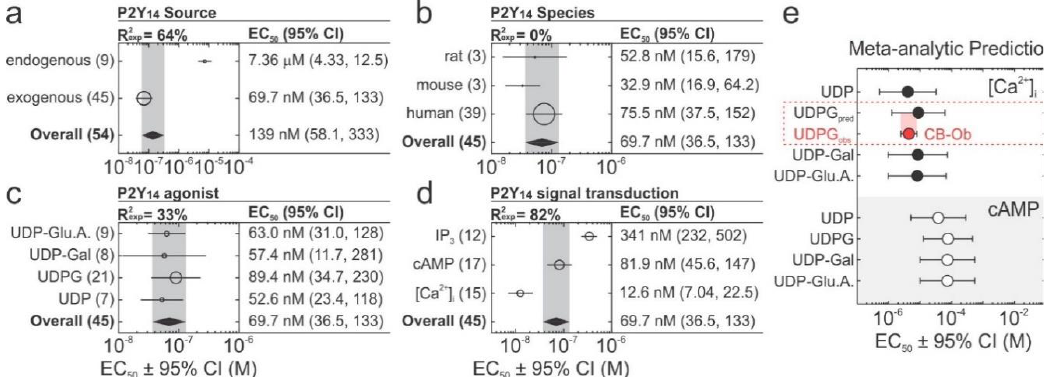
Figure 7. A meta-analysis of P2Y 14 signalling. ( a – d ) Study-level P2Y 14 EC 50 values were estimated by hill functions (fitted to study-level data) and pooled using a random-effects model to obtain subgroup EC 50 estimates for ( a ) P2Y 14 source (endogenous or exogenous); ( b ) P2Y 14 species (human, mouse, or rat); ( c ) uridine agonists used to evoke the response (UDP, UDP-glucose, UDP-galactose, or UDP glucuronic acid); and ( d ) measured outcome (IP 3 , cAMP, or [Ca 2+ ] i ). Panels b – d only included exogenously expressed P2Y 14 data, and IP 3 and [Ca 2+ ] i responses were measured in heterologous expression systems using chimeric Gα protein. 𝑹 𝒆𝒙𝒑𝟐 : Percentage of heterogeneity (i.e., inconsistency between datasets) explained by specified covariates, circles/lines : subgroup means ± 95% CI (marker sizes are proportional to the number of datasets that are shown in parentheses), diamonds/grey bands : overall means ± 95% CI. ( e ) The meta-regression model was used to predict EC 50 of [Ca 2+ ] i response induced by endogenously expressed murine P2Y 14 , and prediction (UDPG pred ) was compared to observed data in CB-Obs (UDPG obs ). UDP-Glu.A, UDP-glucuronic acid; UDP-Gal, UDP-galactose; UDPG, UDP-glucose.